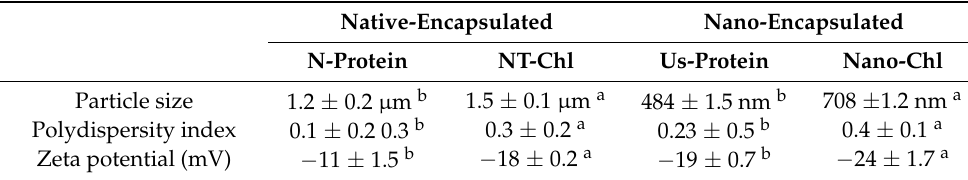
Table 1. Particle size, polydispersity index and zeta potential of native protein, ultrasonicated protein and chlorogenic acid encapsulated in native protein and ultrasonicated